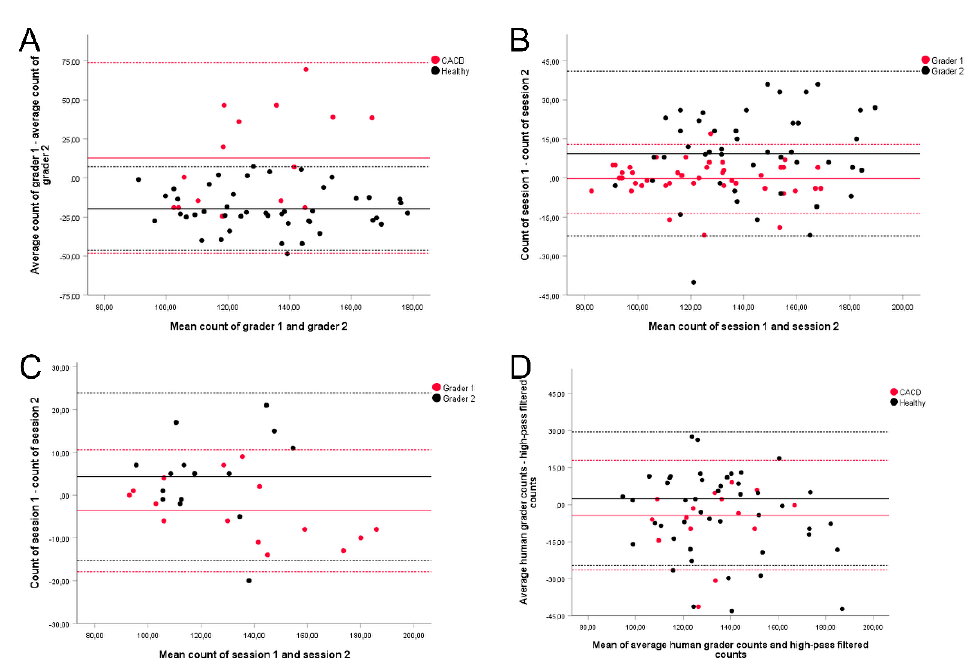
Figure 2. Bland–Altman plots of intergrader differences between healthy participants and CACD patients ( A ), intragrader differences in healthy subjects ( B ), intragrader differences in CACD patients ( C ) and differences between human graders and automated, high-pass filtered counts ( D ).